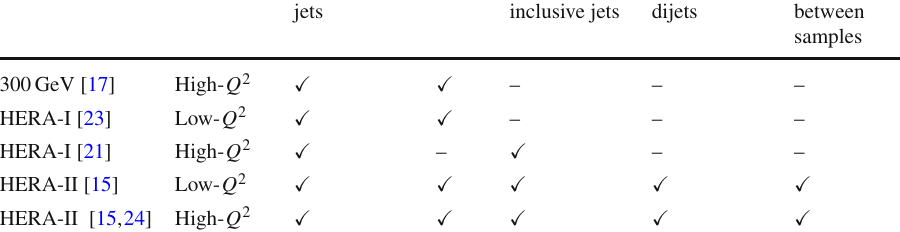
Data set [ref.] Q 2 domain Inclusive